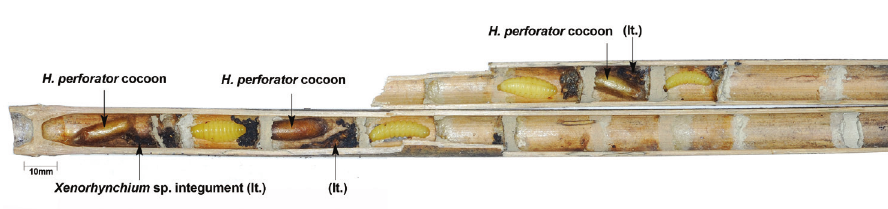
Figure 3. Trap SLT.025.A1 at opening.